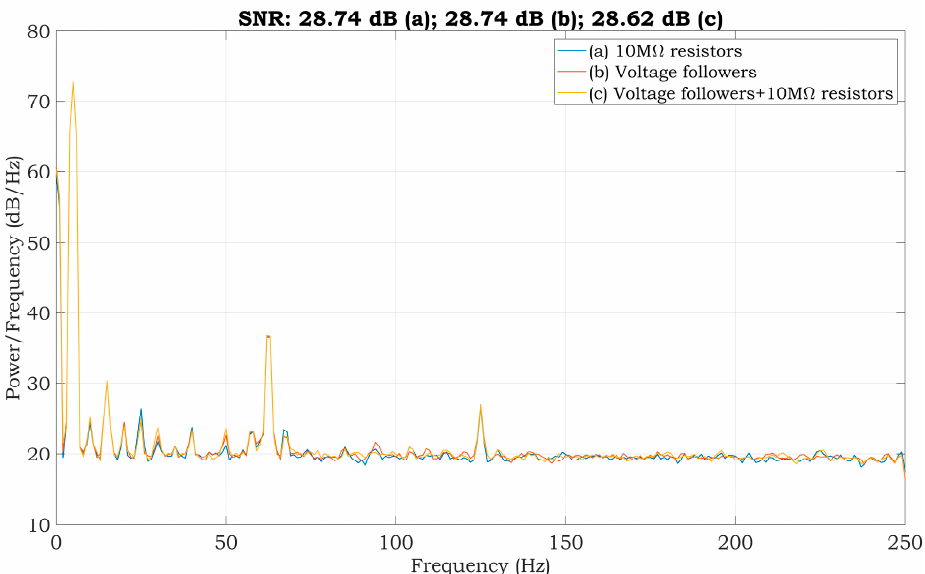
Figure 9. The PSD estimate of the sinewave signal of proposed